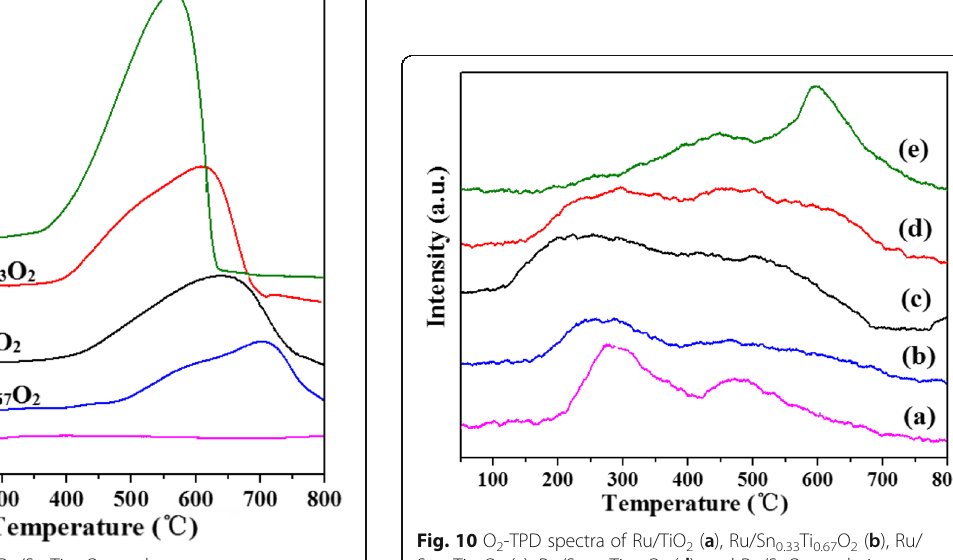
Fig. 9 H 2 -TPR spectra of Ru/Sn x Ti 1 − x O 2